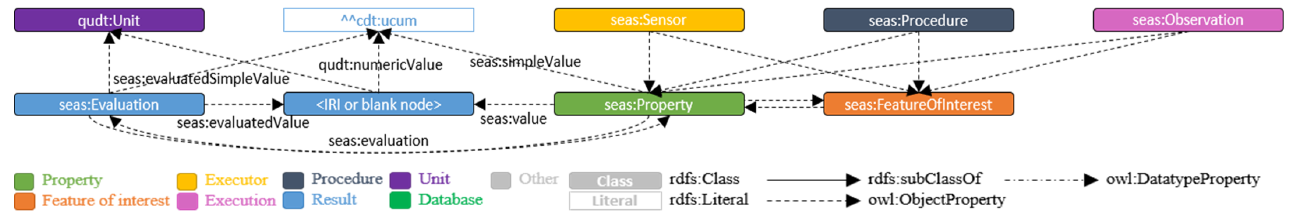
Figure 10. Design pattern of SEAS including multiple methods to describe property values.